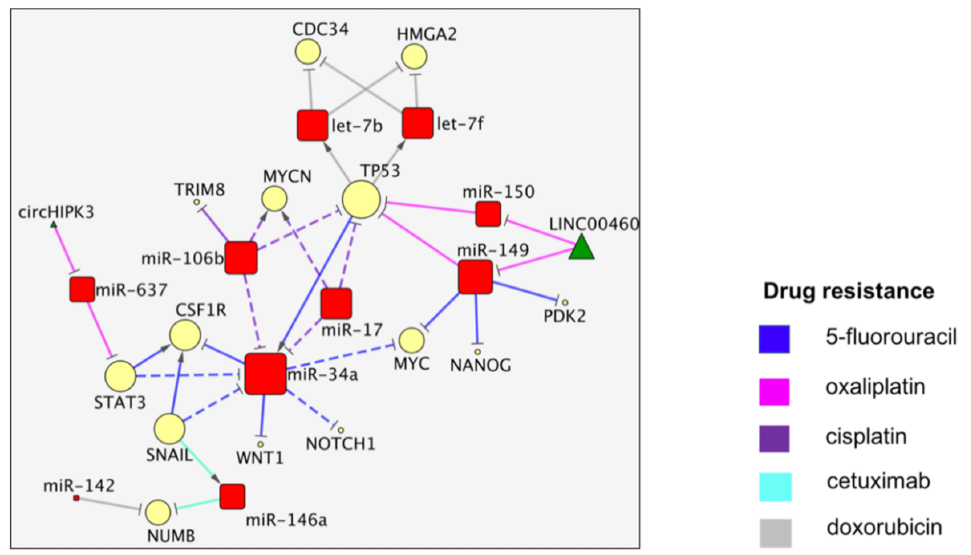
Figure 3. The miR-34a/TP53